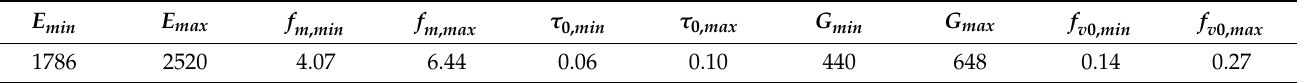
Table 1. Mechanical properties of masonry according to the Masonry Quality Index method (values in N/mm 2 ). E min E max f m ,